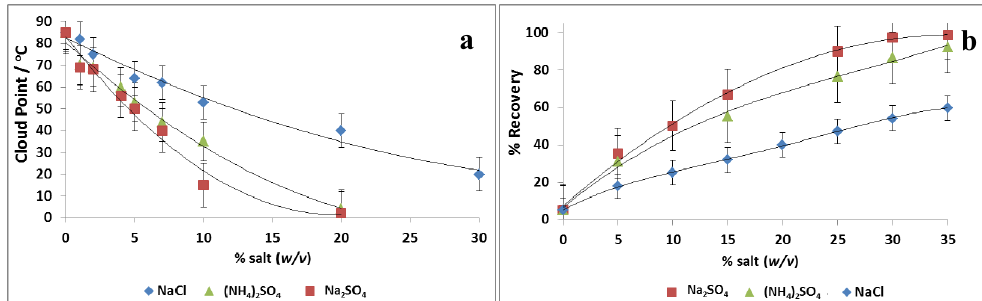
Figure 1. The influence of added salts ( a ) in the phase separation of a mixture of olive leaf extract (total phenols concentration: 2500 ppm) and 4% Tween 80 (w/v) (pH 5 ± 0.2) and ( b ) in the percent of recovery of total phenolics from olive leaf extract; conditions: 4% Tween 80 (w/v), pH 5.0 ± 0.2, settling time 30 min. The total phenol concentration (ppm) is the sum of the concentration of oleuropein, verbascoside, luteolin- O -7-glucoside, apigenin- O -7-glucoside and hydroxytyrosol in the olive leaf extract, which were quantitated with an HPLC-diode array detector